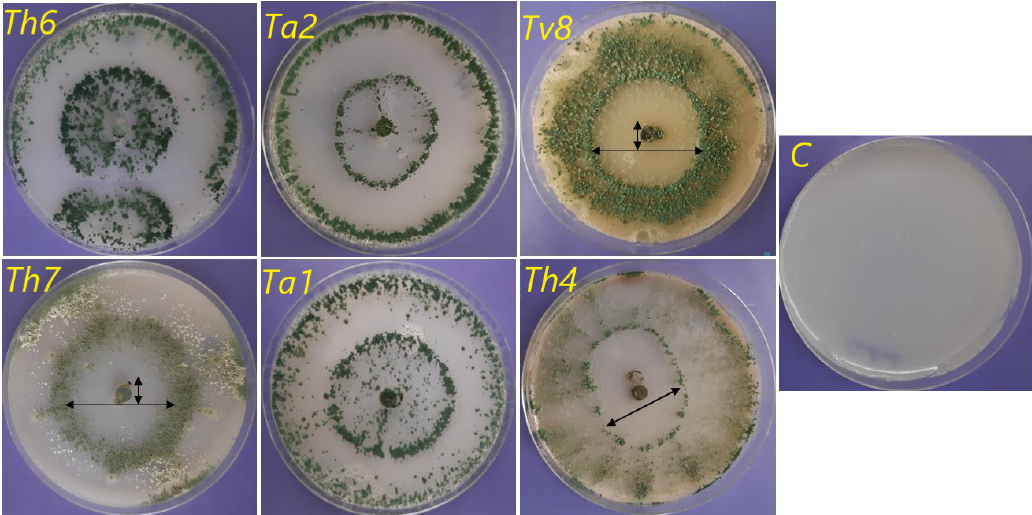
Figure 4. Growth of Trichoderma species on Modified Pikovskaya’s Agar medium (MPA) supplemented with Rock Phosphate (RP) for phosphate -solubilization after seven days’ incubation at 28 ± 0.2 ˚ C.